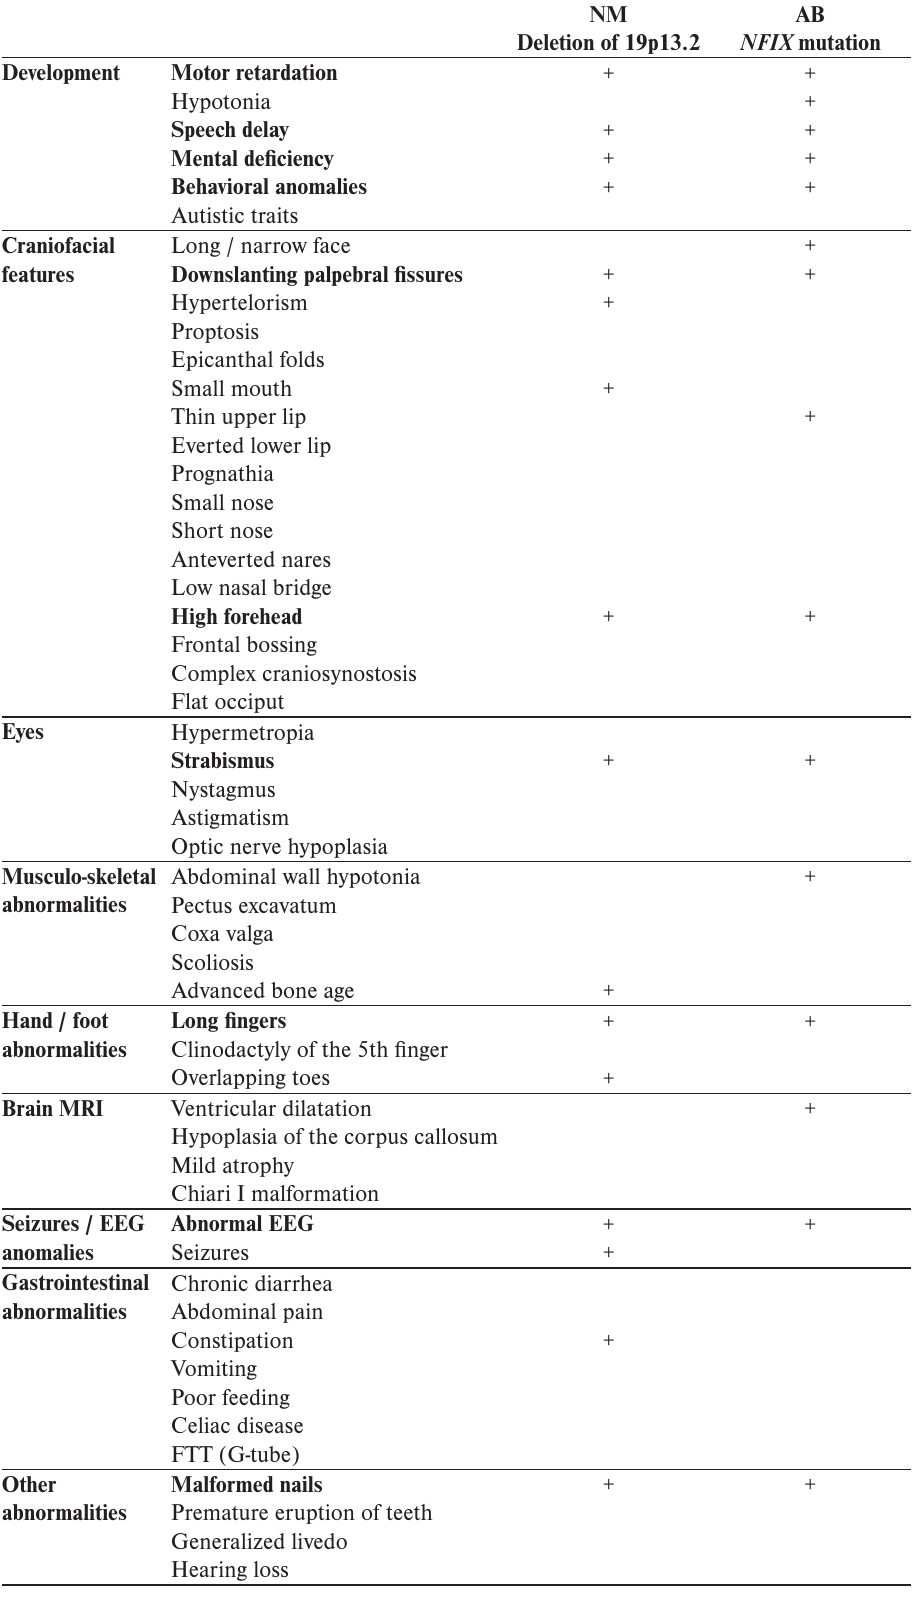
Table 2. Clinical features present in Sotos syndrome 2 described in the literature (symptoms observed in both our patients are marked in bold).